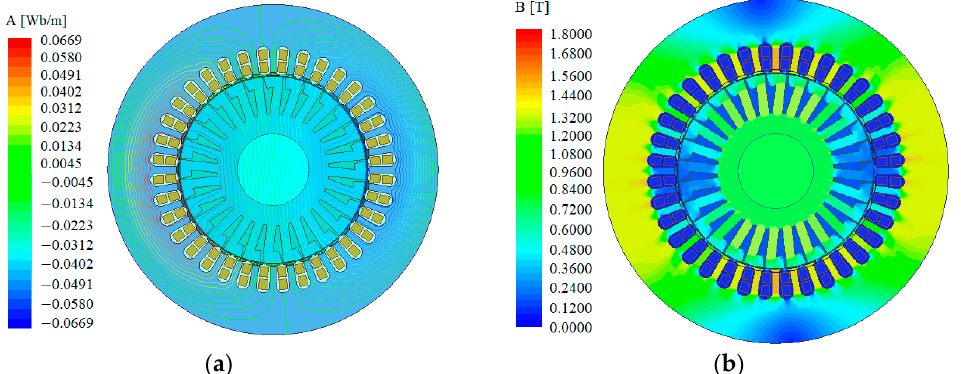
Figure 8. The magnetic lines distribution and the magnetic density diagram of the motor during normal operation: ( a ) magnetic lines distribution; ( b ) magnetic density diagram.